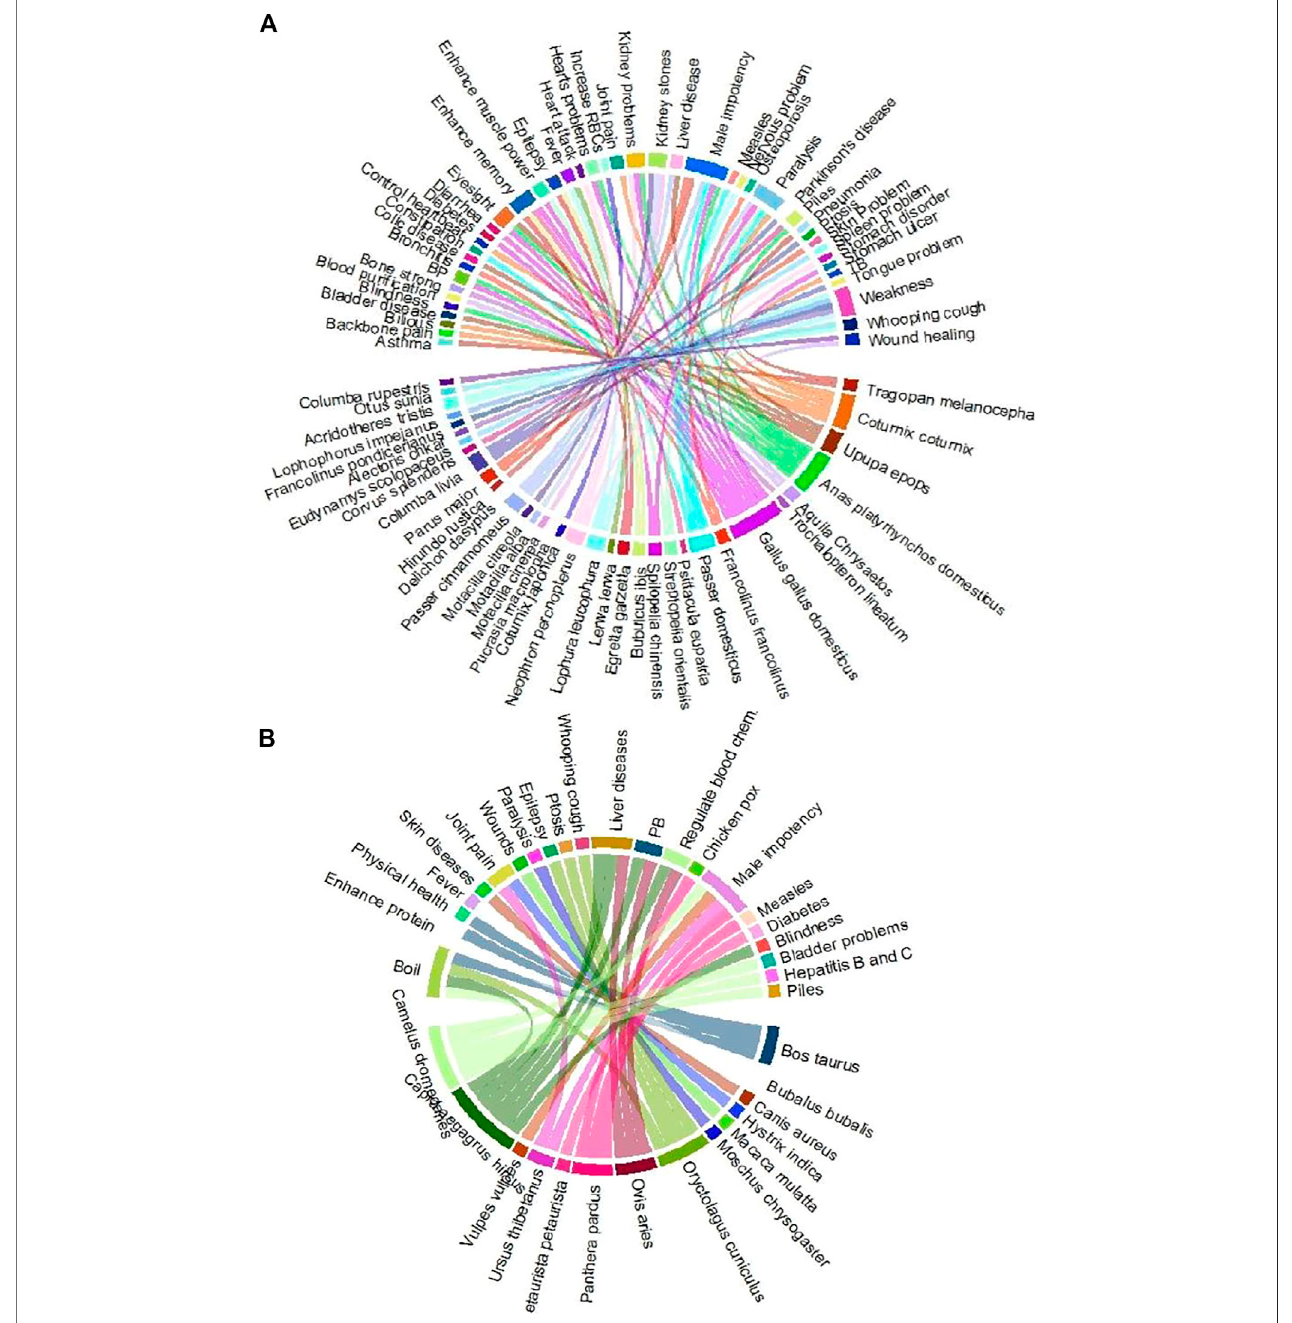
FIGURE 5 | Animal species distribution according to the treatment of various ailments in the Himalayan region of Azad Jammu and Kashmir. Animal species are classi fi ed into different groups such as (A) birds and (B) mammals.